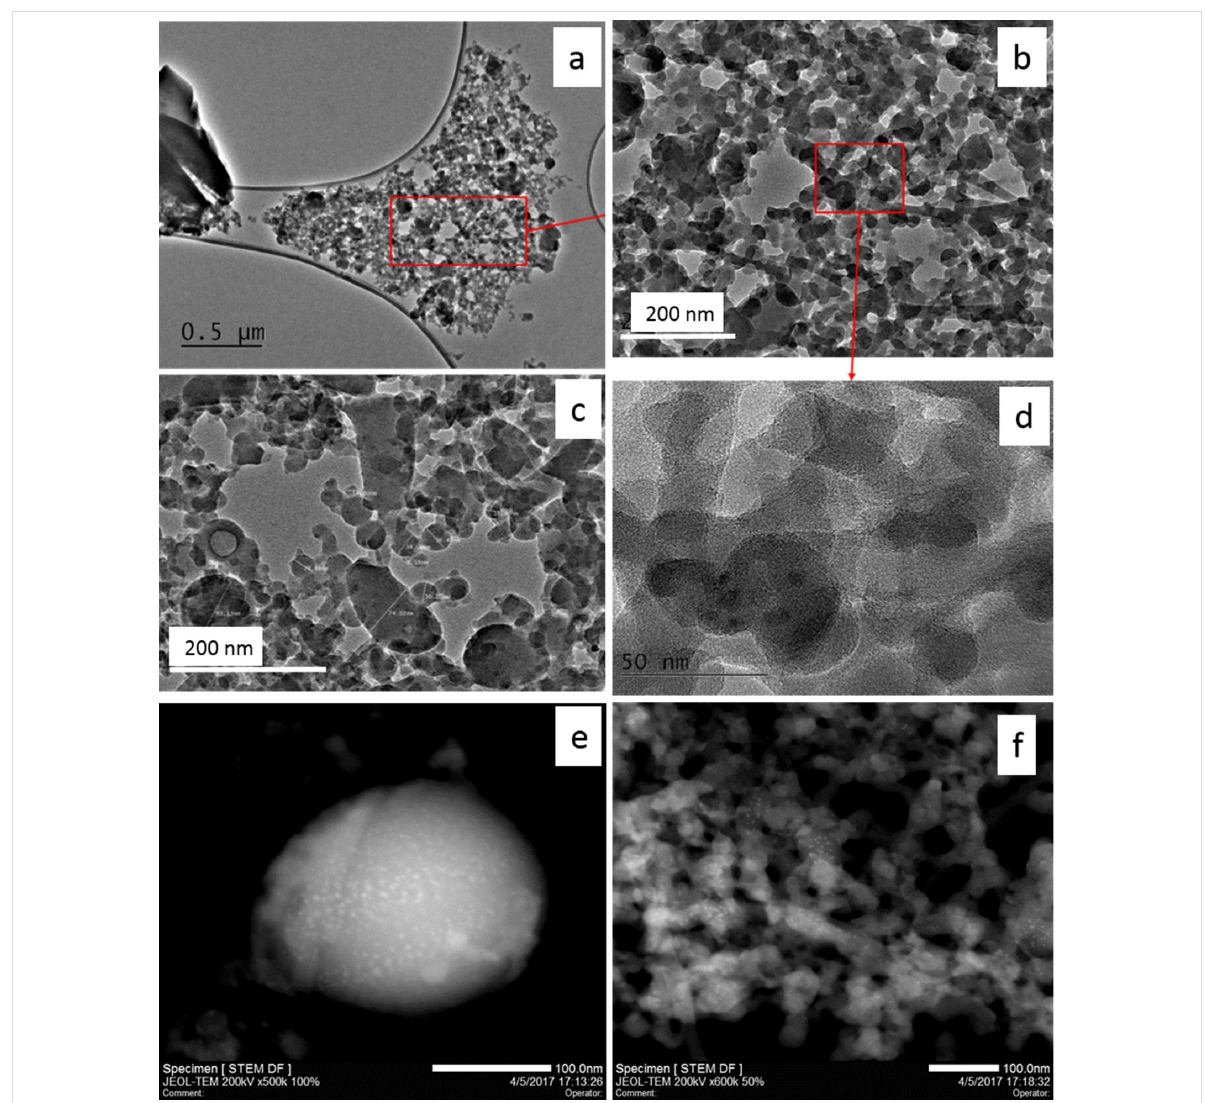
Figure 3: Sample A (SiO 2 +Ge, 33 mJ/pulse); a) TEM image of the region labeled 1 in Figure 1a; b) details of the red square of panel a; c) image of nanoparticles with different sizes; d) details of the red square of panel b; e) STEM image of a single, large nanoparticle; f) STEM image of an agglom- erate/aggregate of small